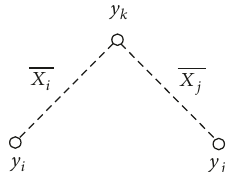
Figure 5: Illustration of two inoperable links with a common